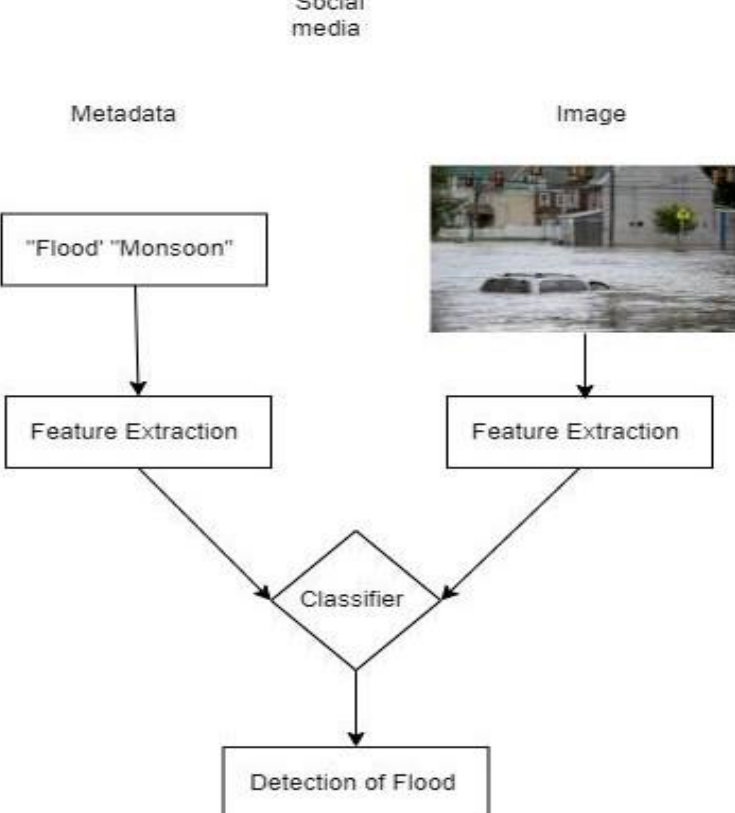
Fig. 4. Flowchart for Disaster detection using Social